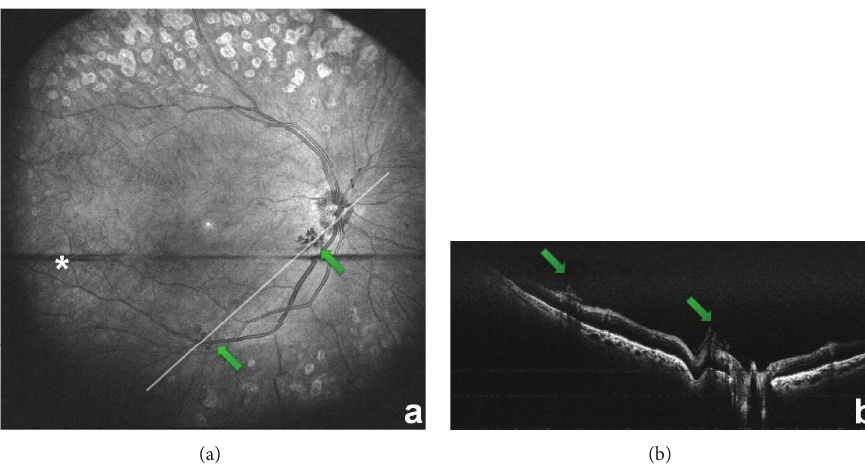
Figure 5: Reconstructed MHz OCT en face wide-field fundus image of right eye (a) with neovascularisations (green arrows); star shows blinking as horizontal black stripe; line represents cross-sectional scan of (b). (b) shows B-frame obtained in postprocessing through the neovascularisations seen in (a), with green arrows pointing at neovascularisations. The two horizontal lines are an artifact from the image